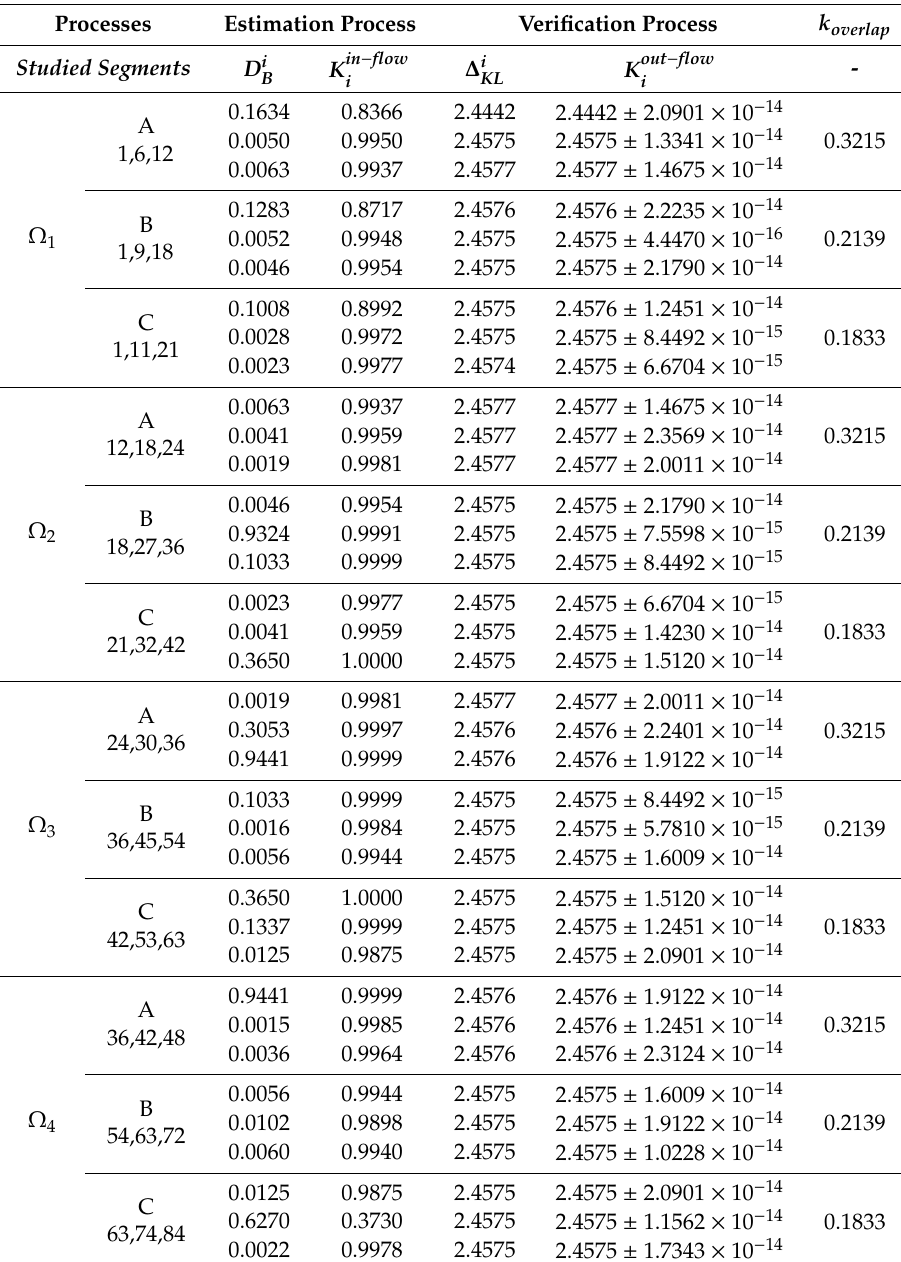
Table 2. The trio-subset enhancement operators of the simulated results. Simulated Results Based on the Modified Shepp–Logan